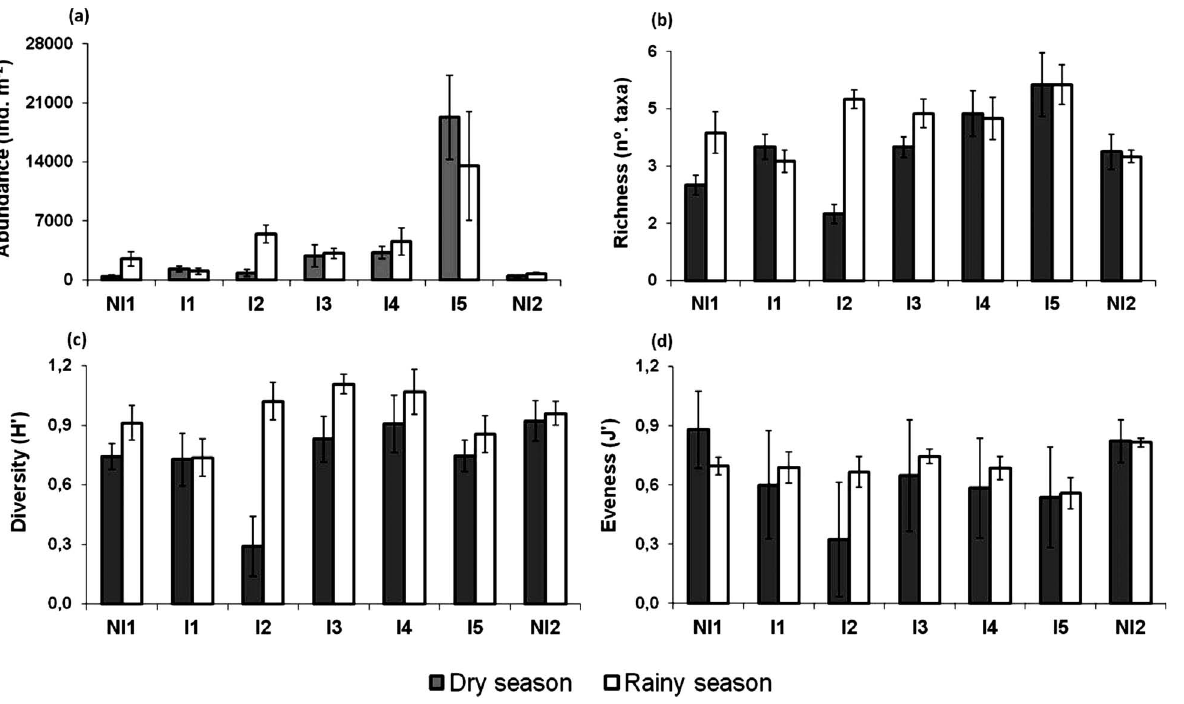
Fig . 4. – Biotic variables (mean±SE): abundance (a); richness (b); diversity (c) and evenness (d). I, impacted sites; NI, non-impacted sites. Table 4. – Results of two-way (site and season) analysis of variance (ANOVA) for the biological variables; * Significant results. Factor Abundance (ind. m –2 )